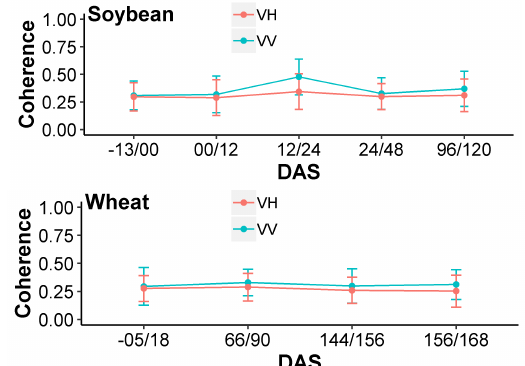
Figure 4. Mean (black line) and standard (error bar) deviation for interferometric coherence.